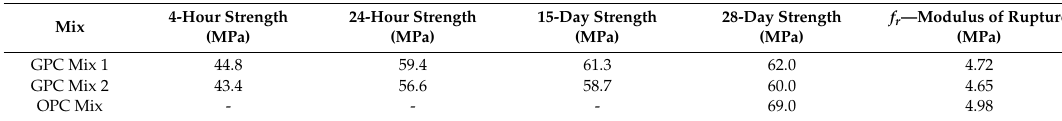
Table 1. Compressive strength of